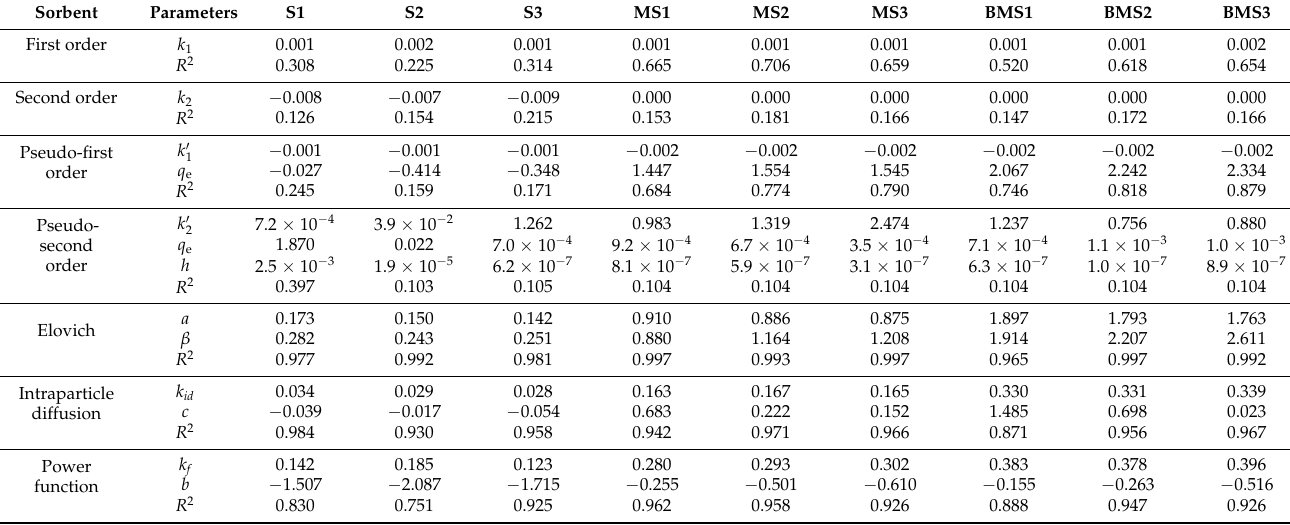
Table 4. Parameters obtained from kinetic models for doxycycline sorption onto different soils (pH 7.41 (S1), pH 8.32 (S2), and pH 8.48 (S3)), manure + S1 (MS1), manure + S2 (MS2), manure + S3 (MS3), mesquite wood-waste-derived biochar +